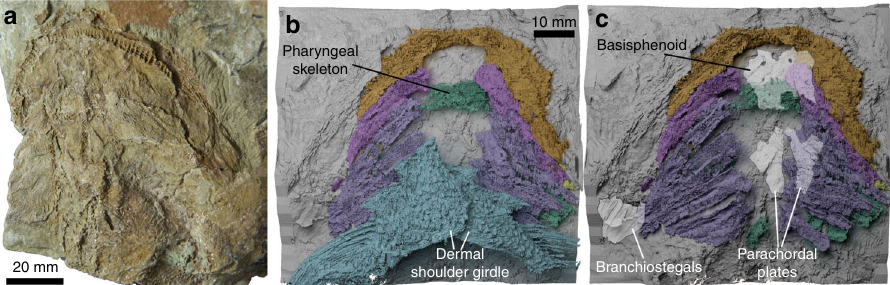
Fig. 1 Ptomacanthus anglicus , specimen NHM P.24919a. a Photograph. b Virtual rendering of the pharyngeal skeleton and dermal shoulder girdle in ventral view, with the moulded surface of the matrix in the background. c Virtual rendering of the pharyngeal skeleton in ventral view, with the moulded surface of the matrix in the background, and the positions of the braincase (as interpreted by Brazeau 18 ) and branchiostegals overlain